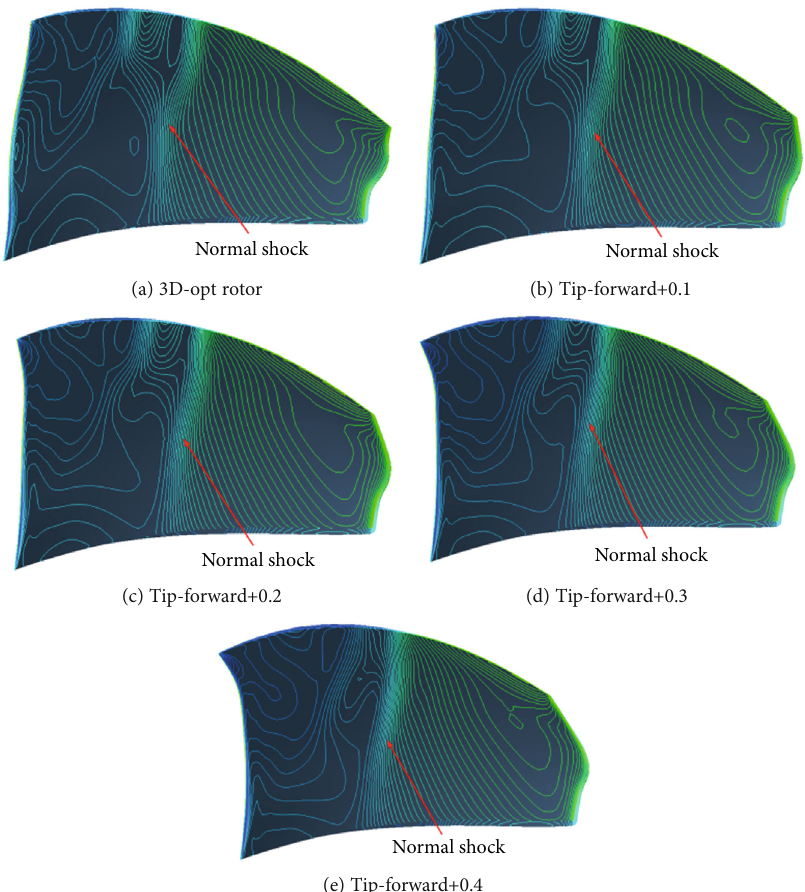
Figure 22: Static pressure distributions on the pressure surface of fi ve blades at the design